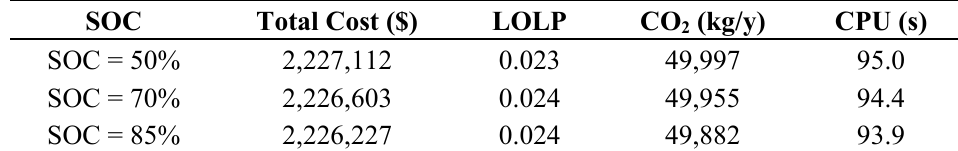
Table 9. Result comparison between different initial